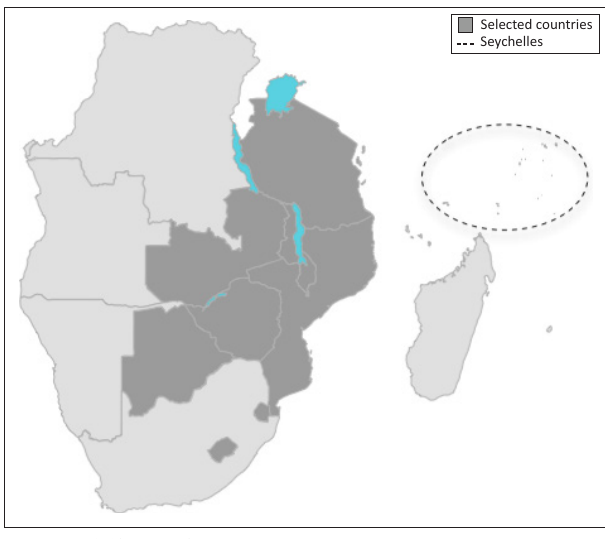
FIGURE 1: The selected cases in the Southern African Development Community region.